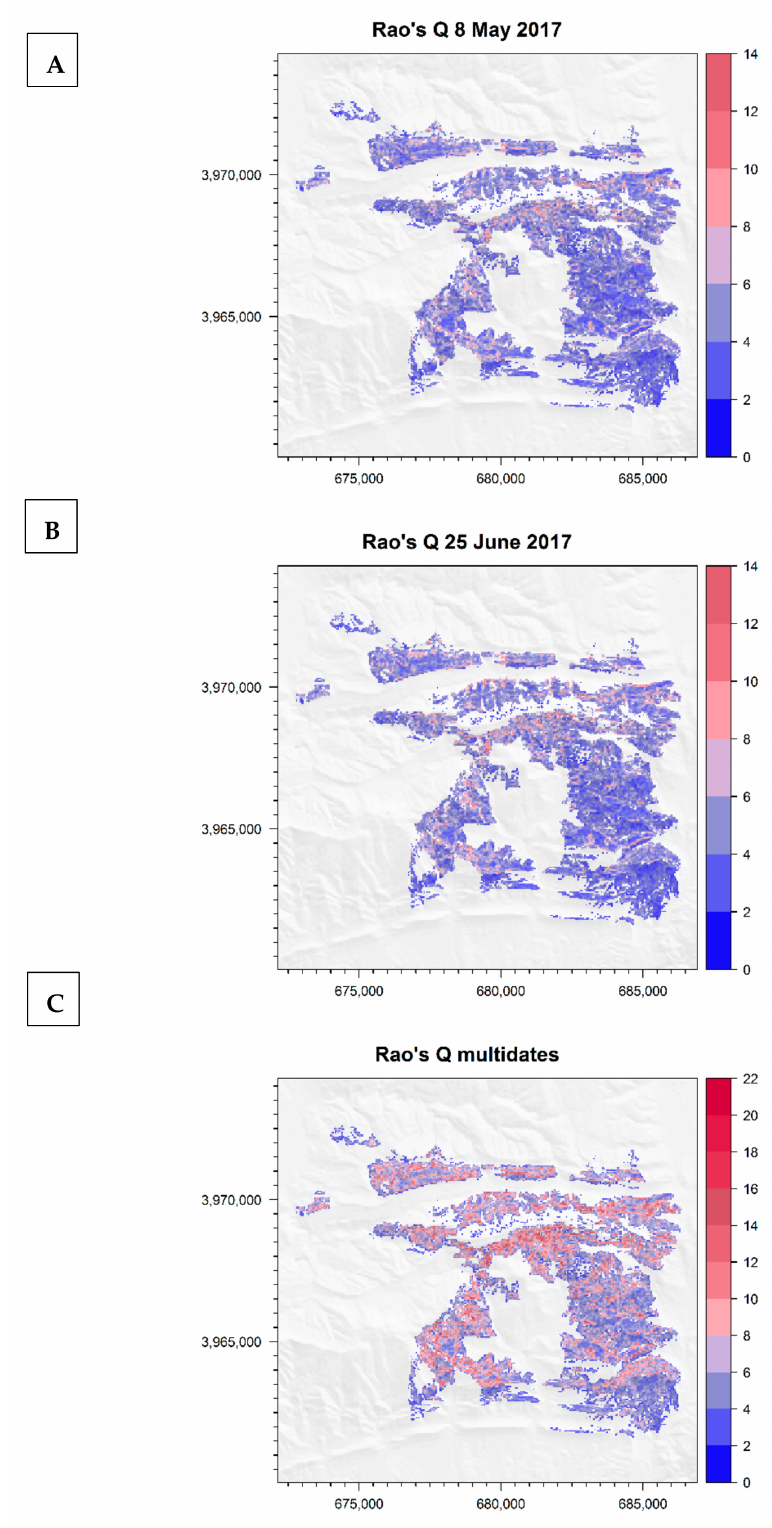
Figure 7. Maps of Rao’s quadratic entropy. ( A , B ) monodate indices, ( C ) multidate